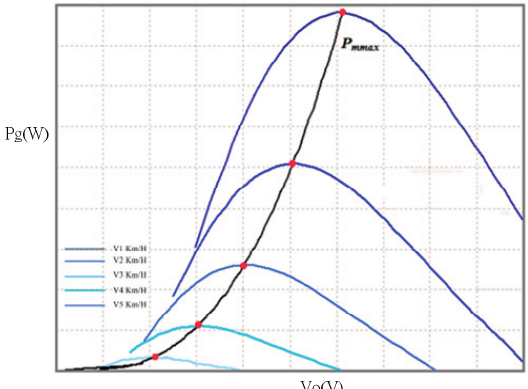
Figure 3. Characteristics curves of an exercise bike generator.